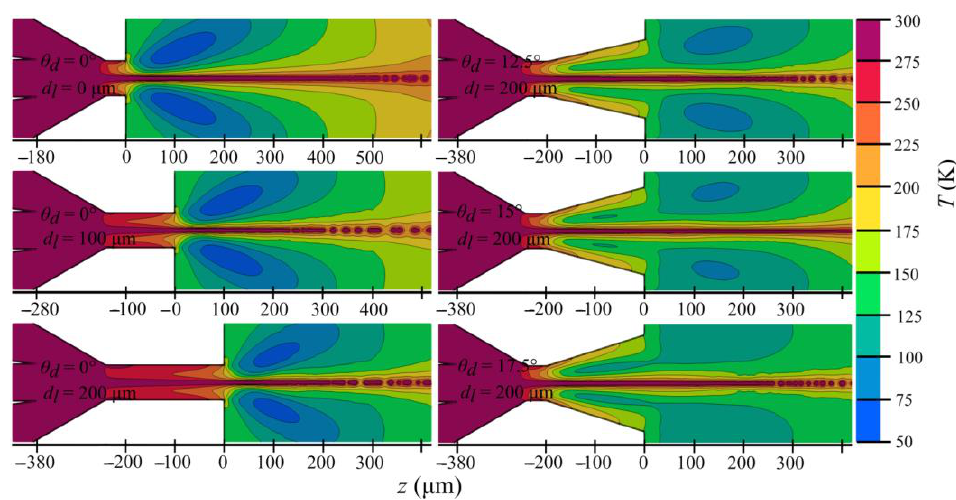
Figure 10. Mach number maps for selected 6 nozzle outlet orifices from Table 3.